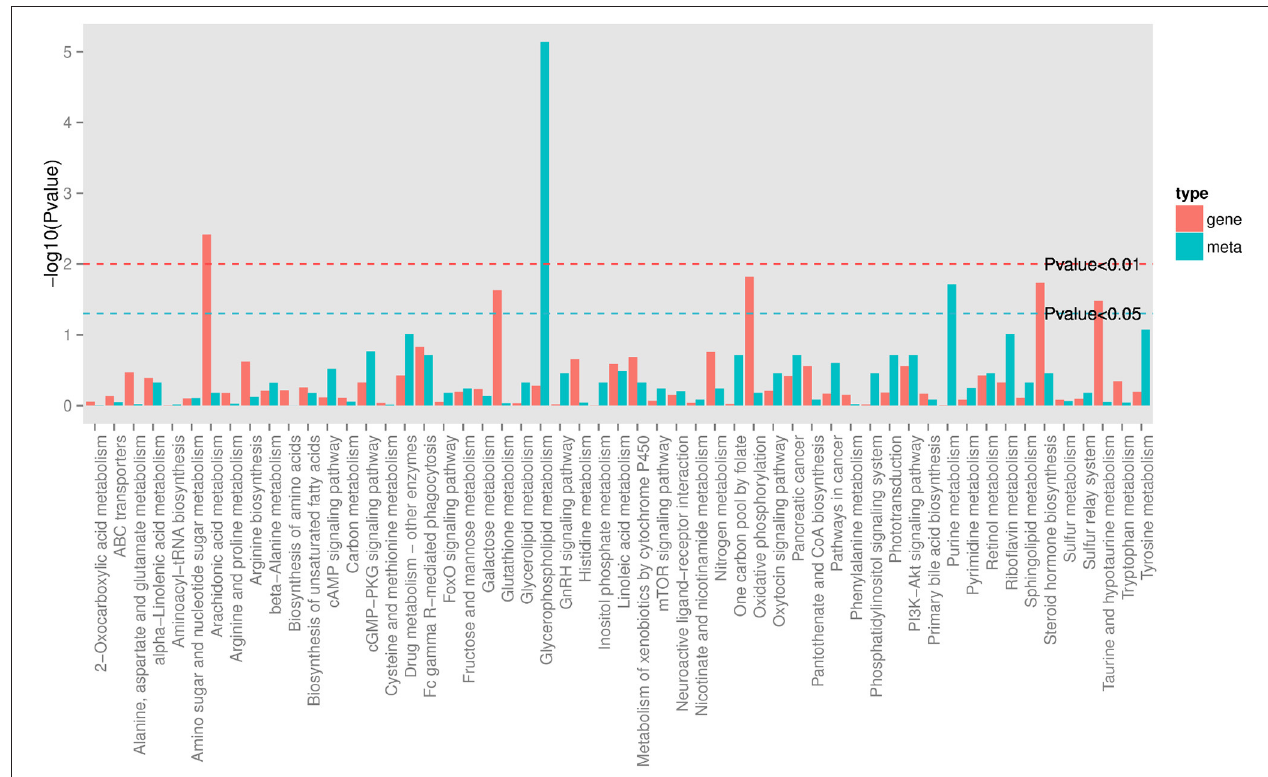
FIGURE 4 | KEGG Pathway co-enriched analysis of DEGs and DAMs. Bar chart showing the number of metabolites covered by each enriched pathway. The Y-axis indicates –Log10 ( P -value) of metabolites while the X-axis indicates the pathway name. Red: gene; blue: